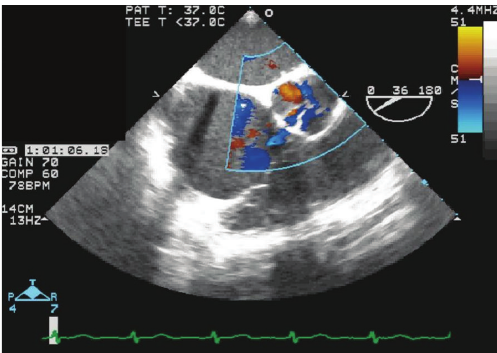
Figure 2: Transesophageal echocardiogram. Short-axis view shows more clearly the perforation and regurgitant jets. See Supplementary CINE file in Supplementary Material available online at http://dx